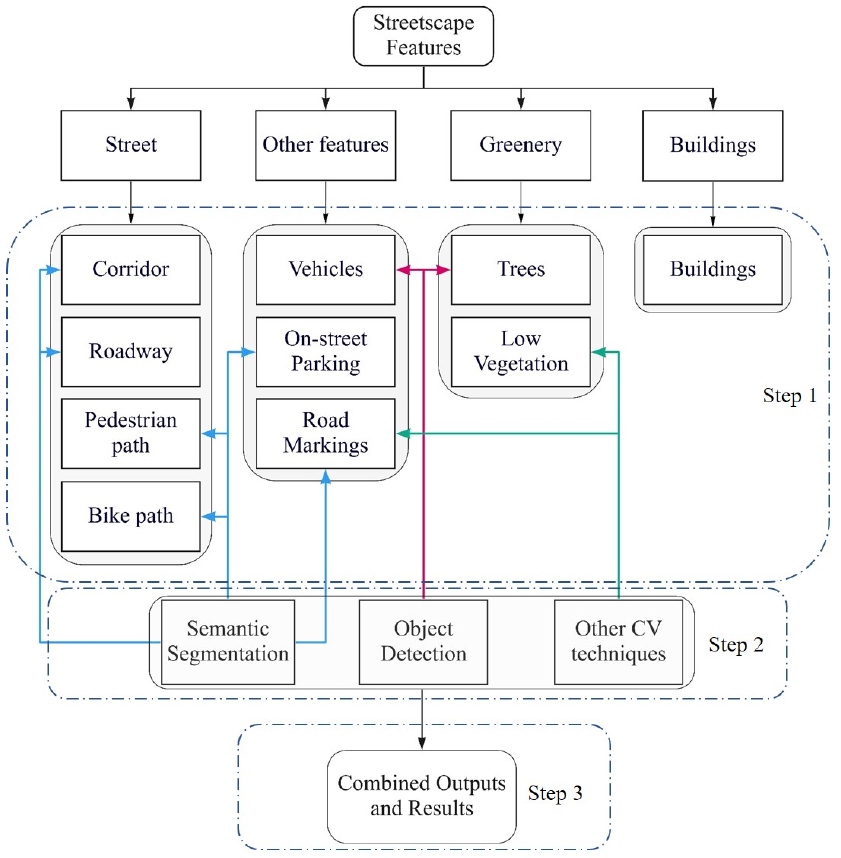
Figure 2. Flowchart showing the overall methodology of the study.